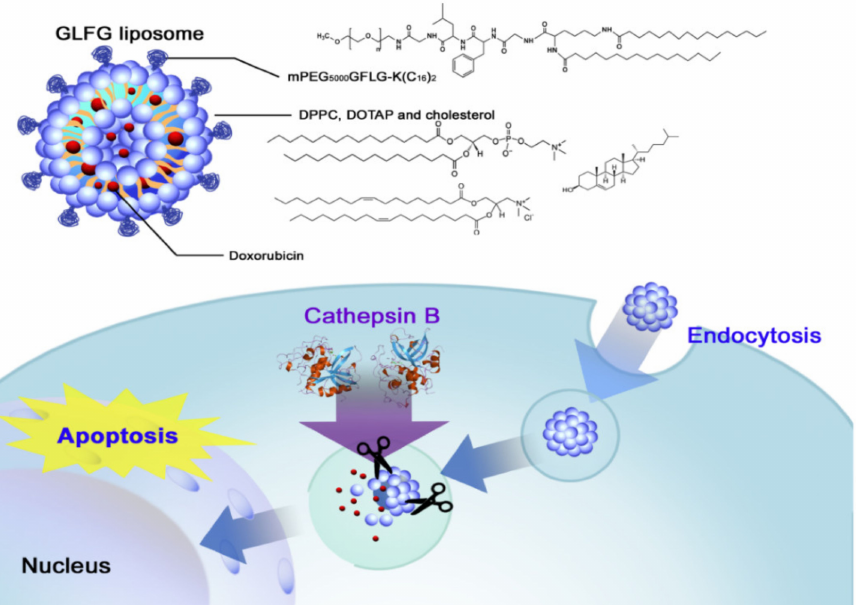
Figure 34. Enzyme-responsive drug release from doxorubicin loaded PEG lipid-GLFG peptide lipo- some designed as a cathepsin B cleavable peptide linker to hydrolyse and release drugs specifically